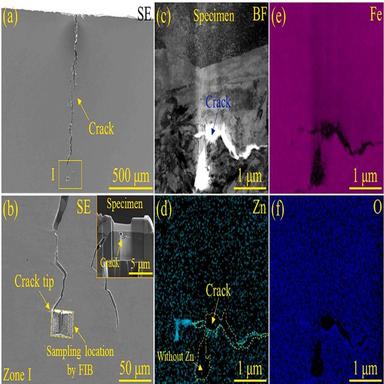
SEM images and STEM results of the region adjacent to the LME crack in the cross-section of the spot weld: (a) secondary electron (SE) image of the region adjacent to the whole LME crack, (b) SE image of the sampling location and the specimen machined by FIB, (c) bright field (BF) image of the region adjacent to the crack tip, and (d)-(f) the corresponding energy dispersive spectroscopy (EDS) mapping to highlight the elements Zn, Fe and O, respectively.